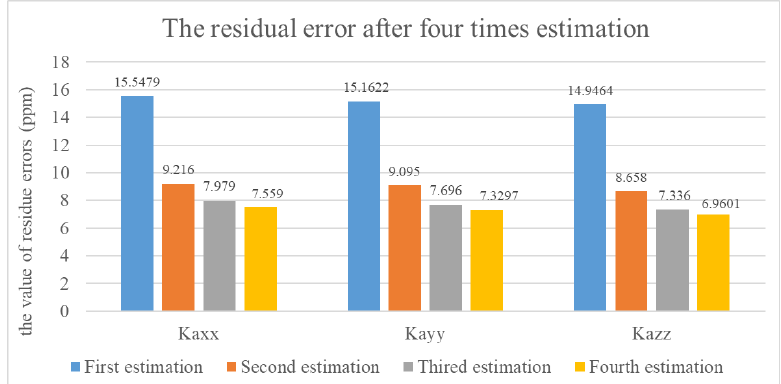
Figure 10. The residual error after each iteration of the scale factor error ACCs.